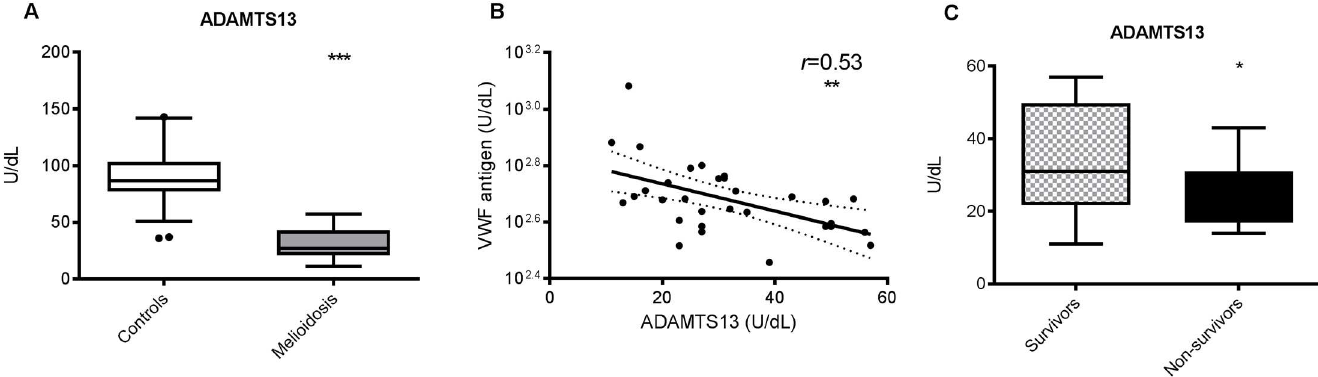
Fig 4. ADAMTS13 levels are depressedin melioidosis patients (A) and are correlated with VWF antigen levels (B), however only weak correlation between ADAMS13and mortality (C). ADAMTS13 = A Disintegrinand Metalloproteinase with a Thrombospondintype-1 motif member 13. The data from 34 melioidosis patients (of whom 12 died) and 52 controls are presented as box plots with Tukey whiskersshowingthe smallest observation, lower quartile, median,upper quartileand largest observation. *** P < 0.001for the difference betweenpatients and controls; (Student’s t- test); P = 0.21 for the difference betweensurvivors (n = 22) and non-survivors (n = 12). For the scatter plot, each dot representsa single study subject from the patient group only (n = 34); the correlation coefficient and * P < 0.05 reportedare for Pearson’s r . The corresponding regressionline for the scatter plot is drawn in bold, with the 95% confidenceinterval for the regression line marked by